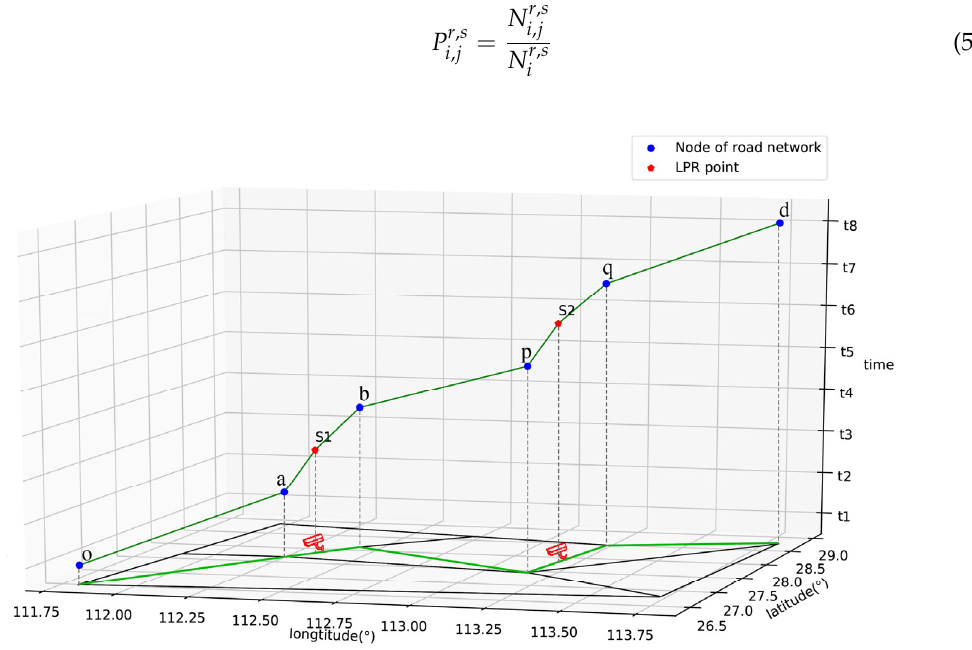
Figure 4. An OD pair decomposed by LPR data. Table 4. One dataset of probability generation of the OD pair ( r, s ).